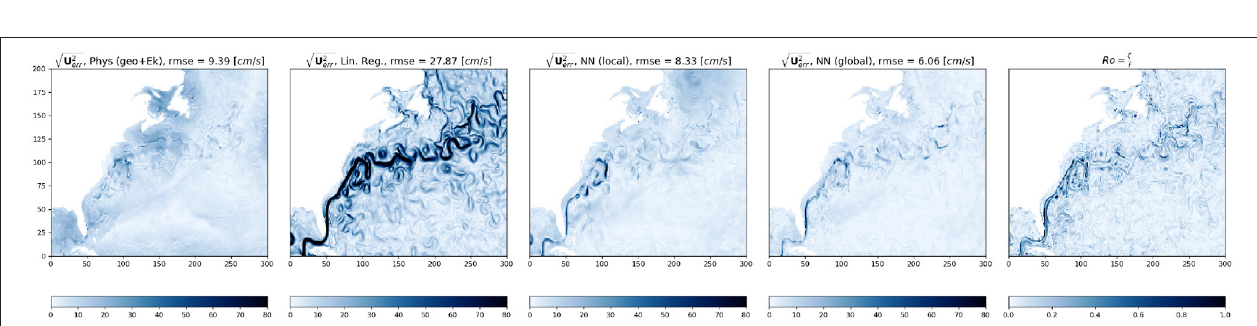
FIGURE 4 | Snapshot of model predicted root square errors for the physics based model (left) and the three different regression models—Linear regression (second from left), neural network, trained on this local domain (third panel) and neural network, trained on the globe (4th panel) compared side by side with the local Rossby Number (Ro, right panel) in the Gulf Stream region indicated by the green box in Figure 2 .